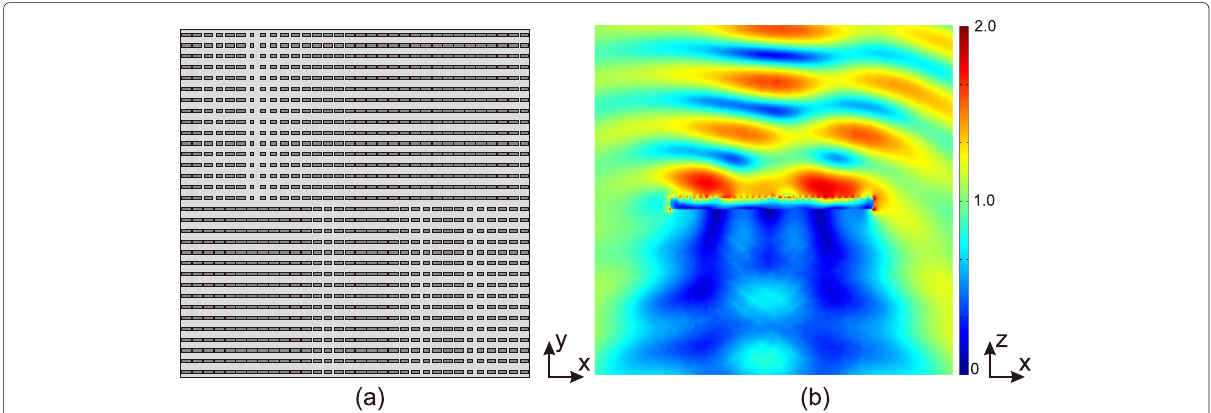
Fig. 7 Results of the multifunctional metasurface. a Configuration of the plate with graphene reflectarray consisting of 36 × 36 graphene patches. The widths ( w y ) of all graphene patch are taken as 4 μ m, and values of w x are selected to realize the phase discontinuity condition as shown in Fig. 6. b The magnitude of the electric field of the reflected vortex wave of l = 1. The incident wave is an x -polarized electromagnetic wave with normalized electric field, impinging normally from the top. The wave is deflected by 30 ◦ towards x -direction